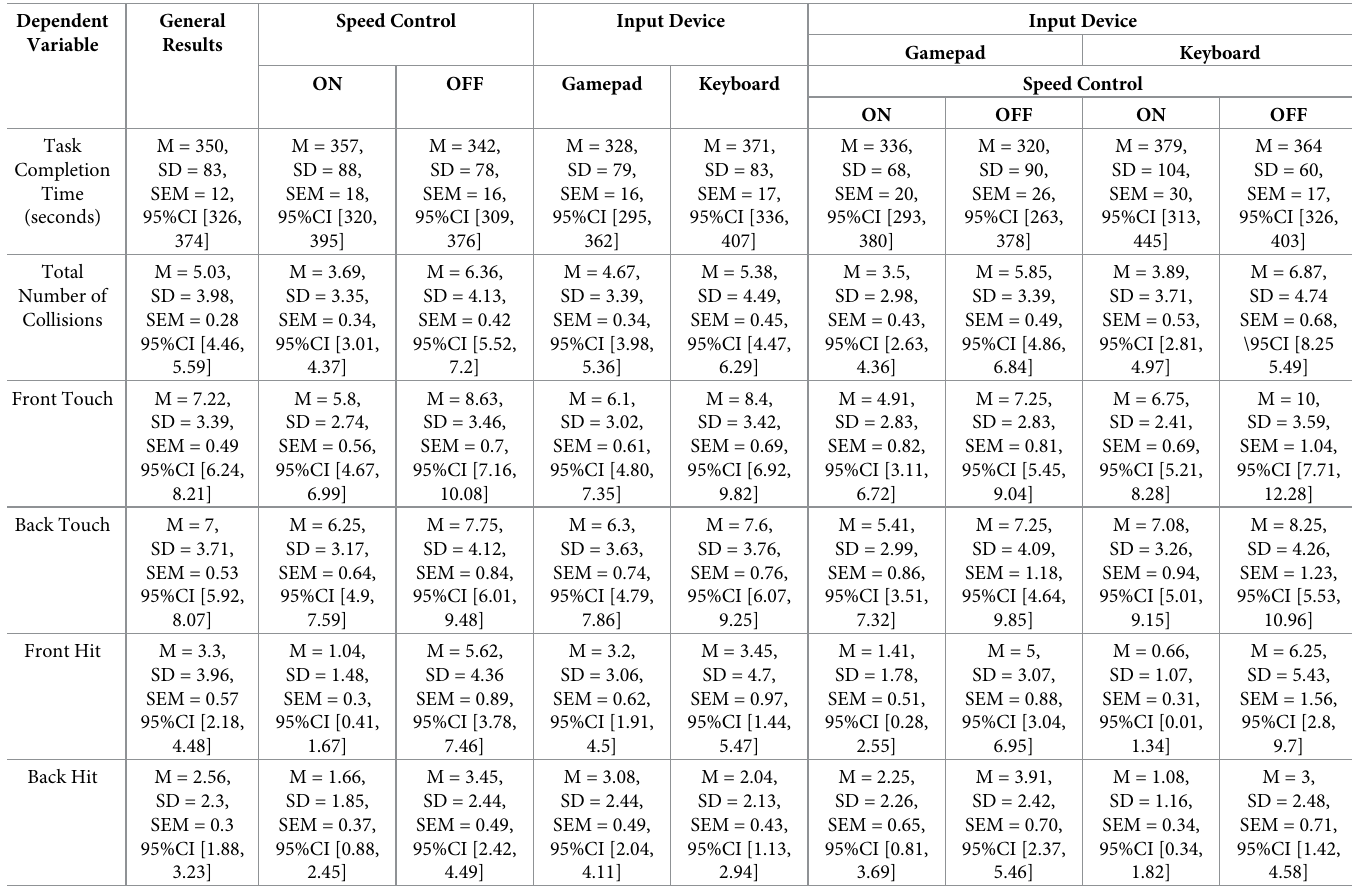
Table 2. Mean (M), Standard Deviation (SD), Standard Error of Mean(SEM) and 95% Confidence Intervals (CI) results for study